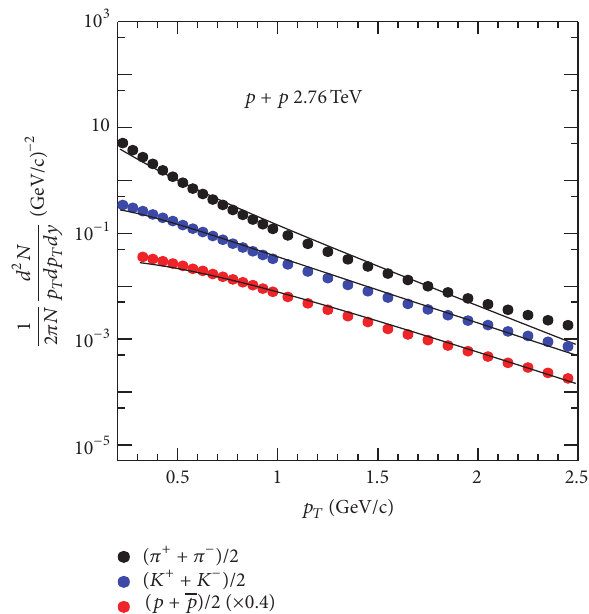
Figure 16: Fitting of invariant 𝑝 𝑇 spectra with Tsallis distribution including radial flow using (8) for 𝜋 + [18], 𝐾 + [18], and 𝑝 [18] in most peripheral Au + Au collisions at √𝑠 NN = 200 GeV.